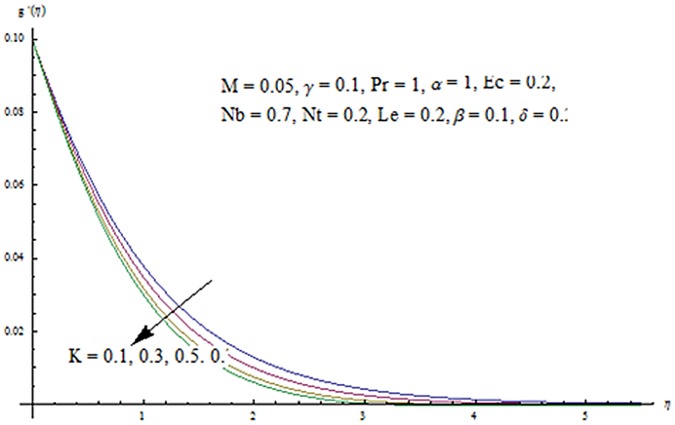
Influence of K on g′.